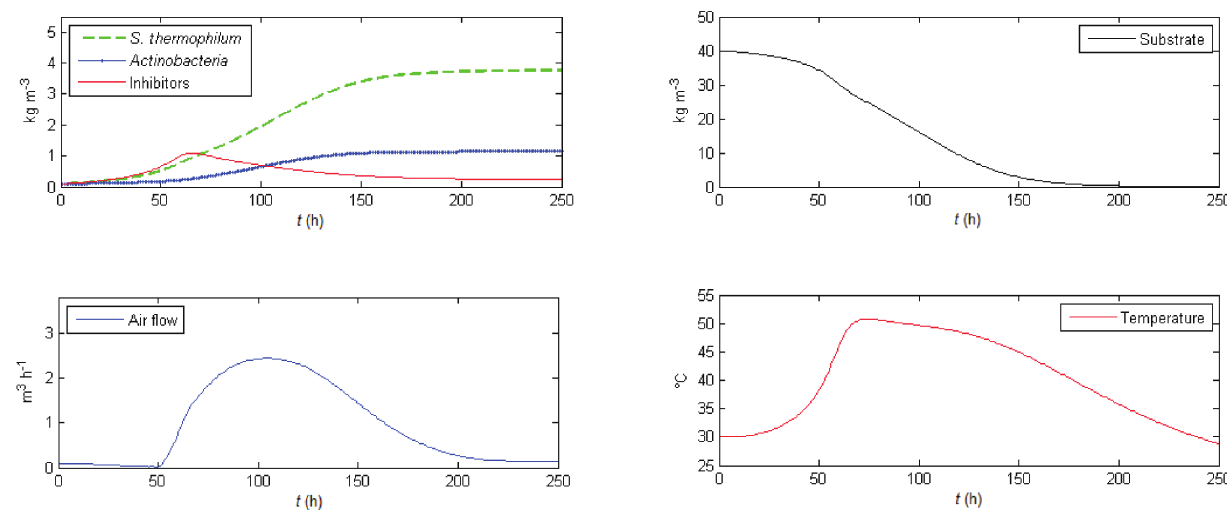
Fig. 6 – SSF model optimal control with u